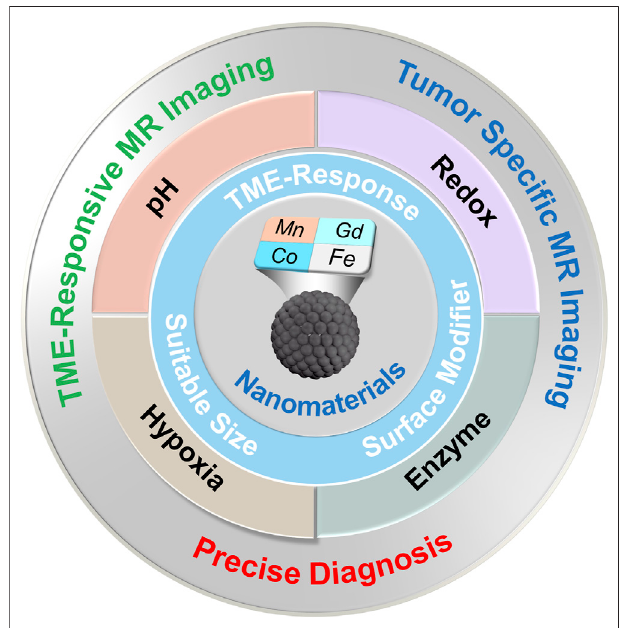
FIGURE 1 | General strategies to synthesize nanotheranostic agents for TME-responsive